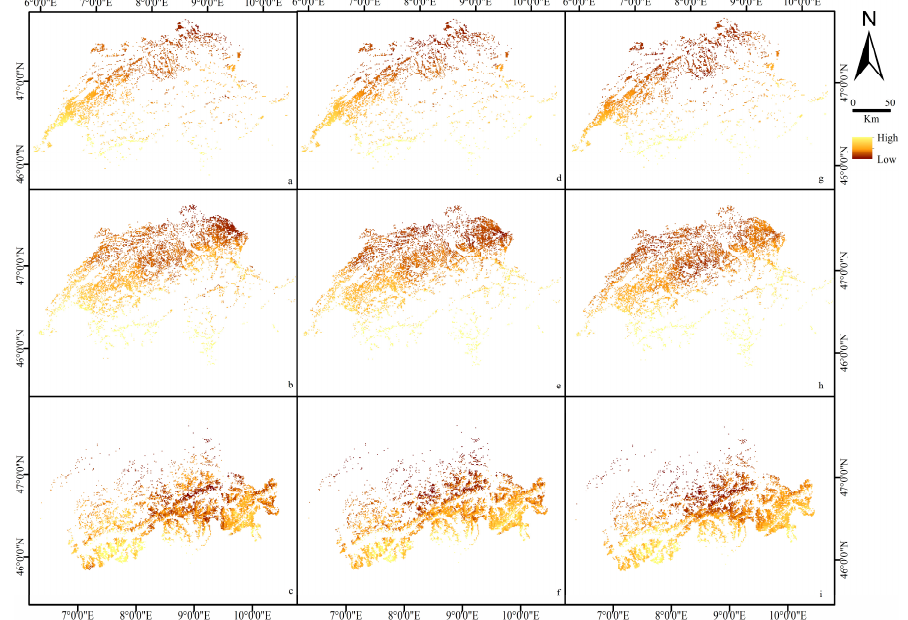
Figure A3. Spatial variability of yearly relative sunshine duration: (a–c) croplands (36–57%), croplands/natural vegetation mosaic (36–57%), and grasslands (36–57%), respectively, for the year 2000; (d–f) croplands (40–61%), croplands/natural vegetation mosaic (40–62%), and grasslands (41–63%), respectively, for the year 2007; and (g–i) croplands (35–56%), croplands/natural vegetation mosaic (34–55%), and grasslands (35–55%), respectively, for the year 2010.